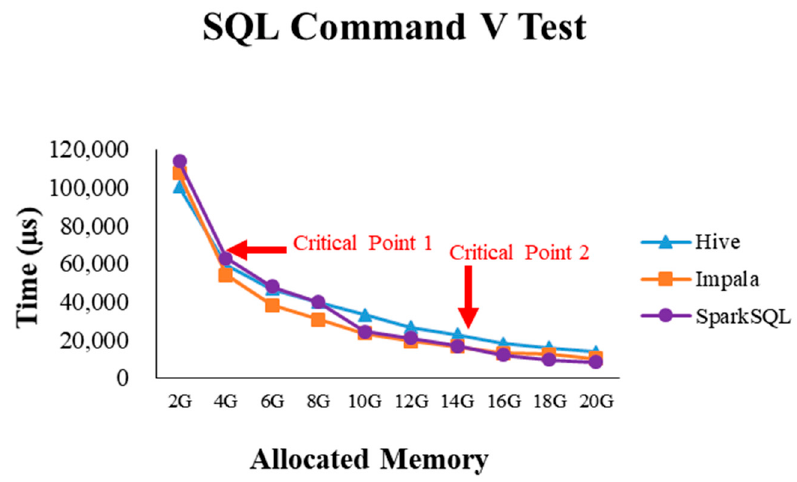
Figure 11. The average execution time of one record by SQL command V.